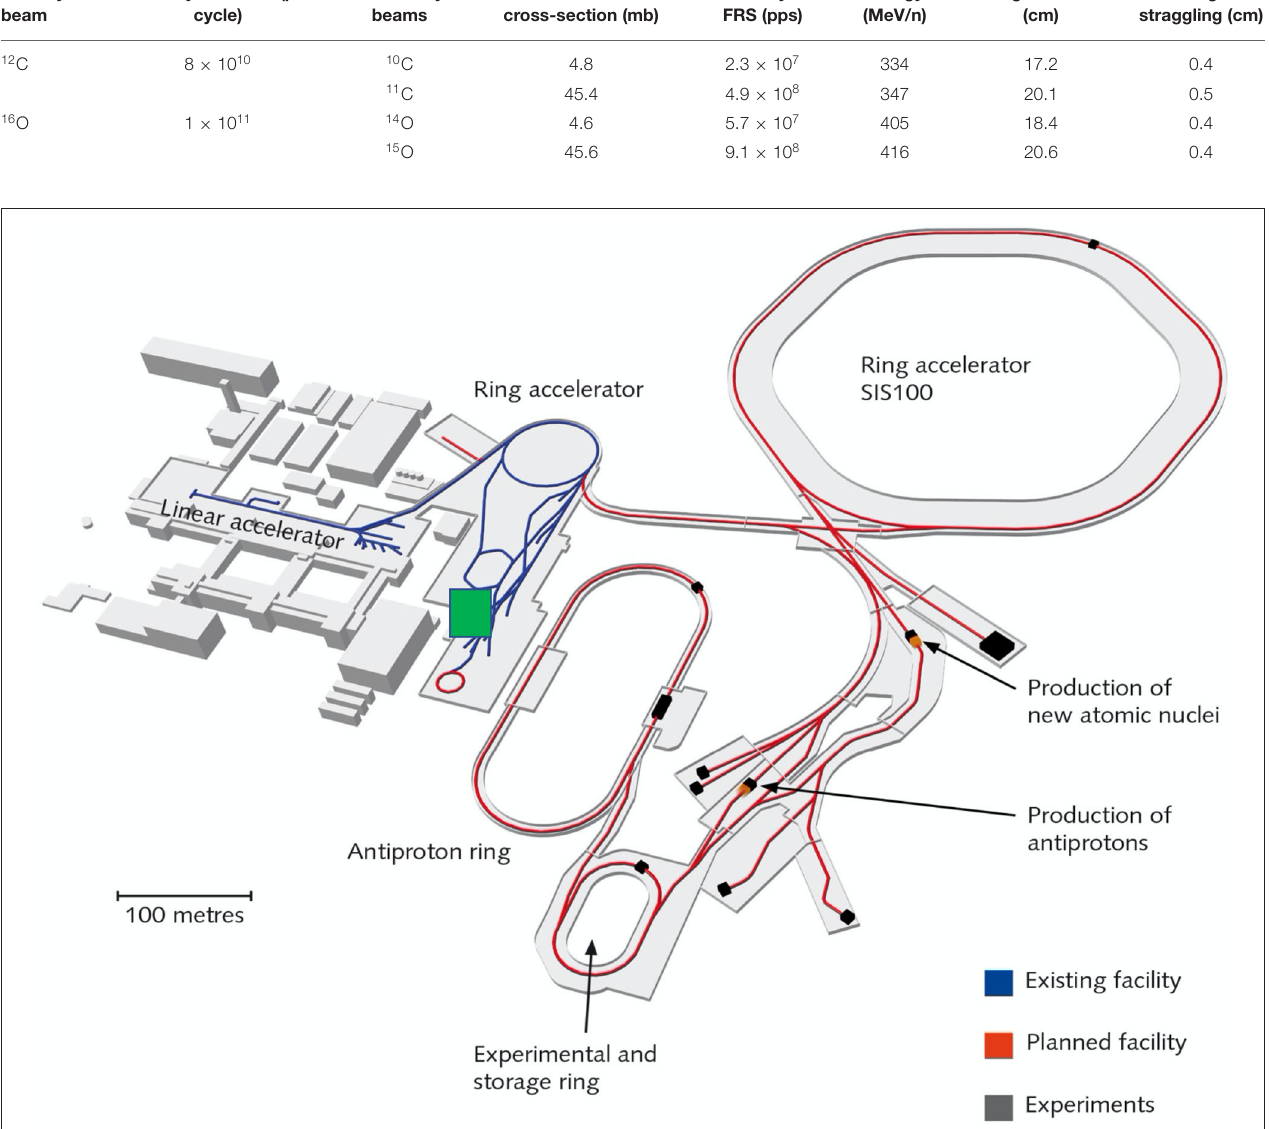
FIGURE 8 | Layout of the FAIR facility under construction in Darmstadt. The blue lines represent the current accelerator, including the SIS18 ring, and the red lines represent the new beam pipes under construction. BARB will work on the SIS18 and its exit beamline in Cave M (indicated by a green square in the map), previously used for the therapy